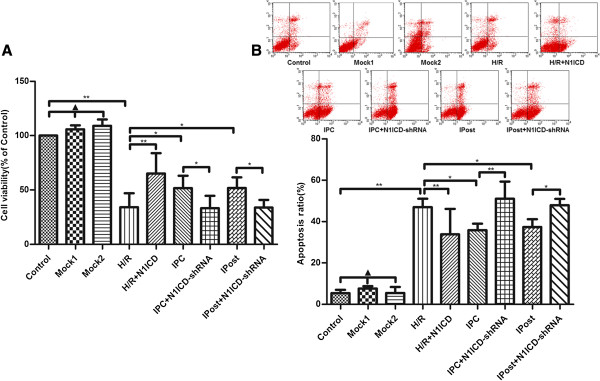
Myocardial IRI is mitigated by activated Notch1 signaling. A, Myocardial cell viability was enhanced by ectopic expression of N1ICD and inhibited by knockdown of N1ICD. B, IRI induced apoptosis was inhibited by ectopic expression of N1ICD but promoted by knockdown of N1ICD. The apoptosis of H9c2 cells was detected based on Annexin V/FITC and PI staining and flow cytometry. Data were presented as mean±SD, n=3. Mock1 indicated cells infected with empty vector, Mock2 indicated cells infected with vector containing nonspecfic sequences. ▲P>0.05, *P<0.05, **P<0.01.